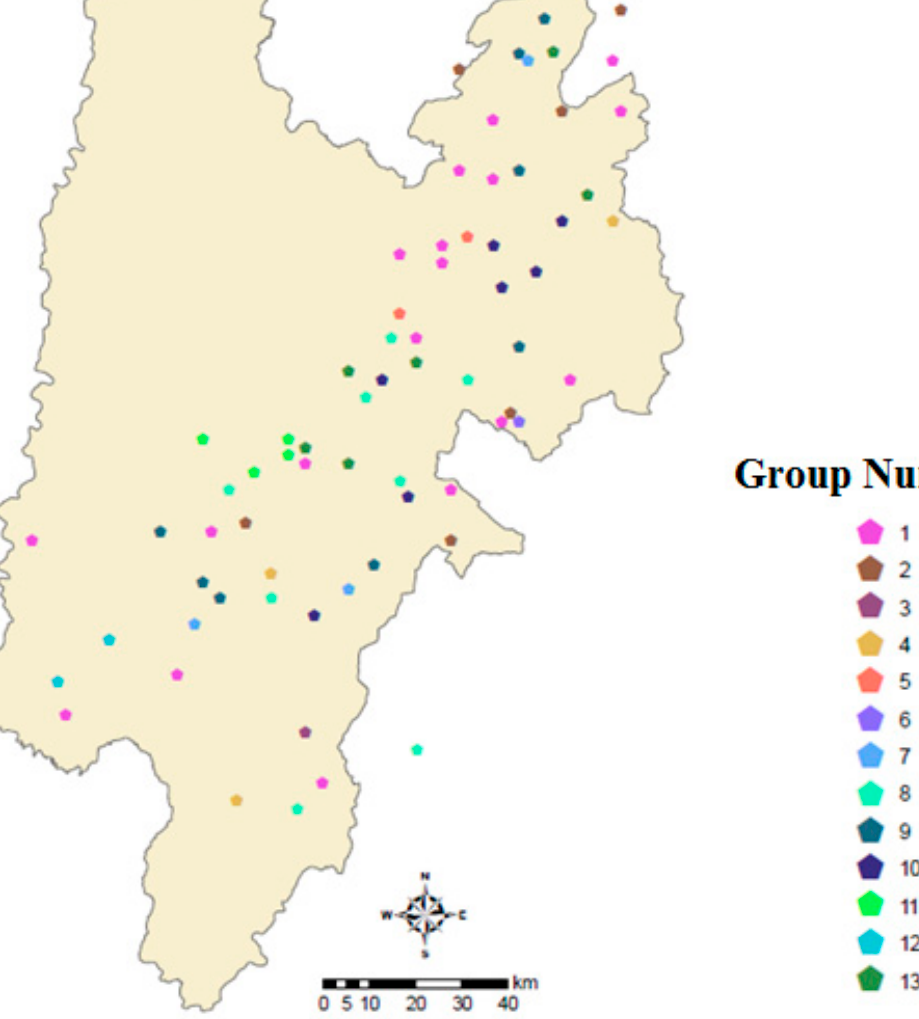
Figure 6. Geographical distribution of groups for the study area in Cundinamarca, Colombia.